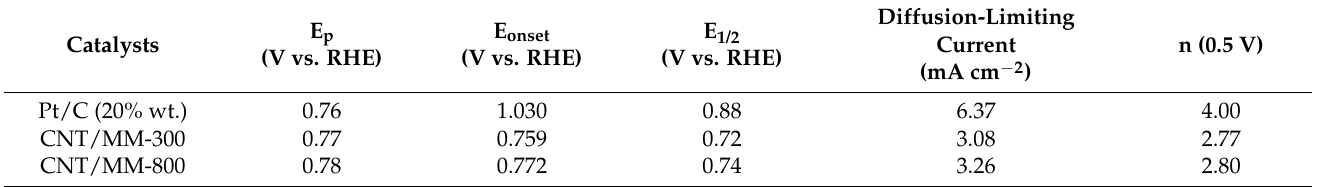
Figure 6. ( a ) CV curves of obtained electrocatalysts in an N 2 and O 2 -saturated 0.1 M KOH solution; ( b ) LSV curves of CNT/MM-300, CNT/MM-800 and Pt/C catalysts measured at a scan rate of 5 mV s − 1 and a rotation rate of 1600 rpm in O 2 -saturated 0.1 M KOH solution; ( c ) number of transfer electrons in the oxygen reduction reaction. Table 2. ORR performance parameters of representative samples and commercial Pt/C catalysts tested in alkaline media. Diffusion-Limiting E p E onset E 1/2 Catalysts Current n (0.5 V) (V vs. RHE) (V vs. RHE) (V vs. RHE) (mA cm − 2 ) Pt/C (20%